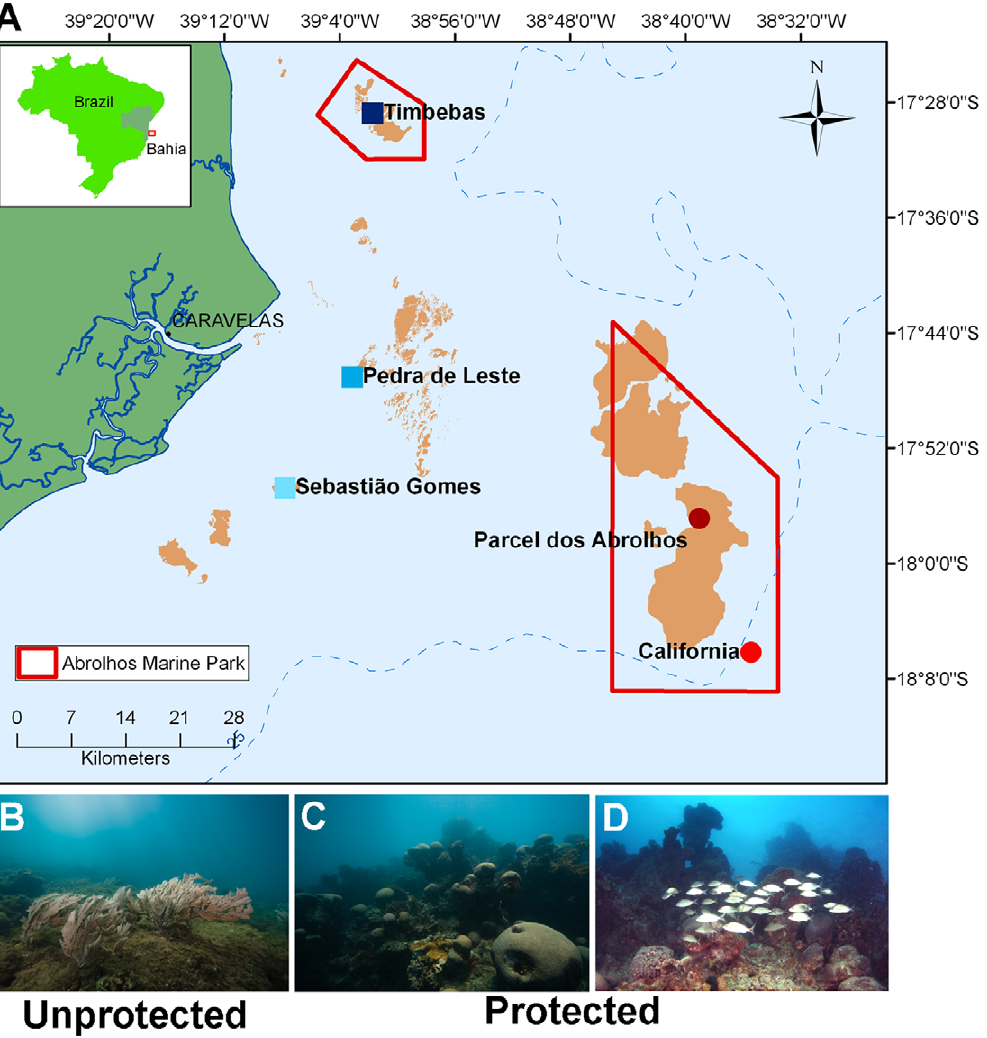
Figure 1. Study area. A ) The five reef sites are indicated. Unprotected (inner) reef locations are represented as purple/blue squares, and protected (outer) reefs are represented as red circles. The lines in red represent areas under Marine National Park of Abrolhos management. The California Reef is within the MPA. B–D. Representative pictures of coral cover in unprotected and protected areas showing the differences in coral cover. B ) Unprotected (Sebastia˜o Gomes) site. Very few coral colonies. C ) Protected (Parcel dos Abrolhos) site. High cover of Mussismilia braziliensis . D ) Protected (Parcel dos Abrolhos) site. High cover of Mussismilia braziliensis and M. hartii . High fish biomass.